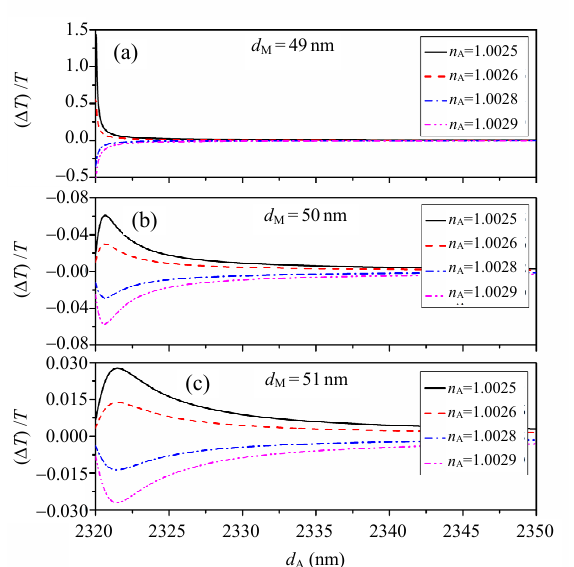
Fig. 8 Sensitivity versus d A of three structures.